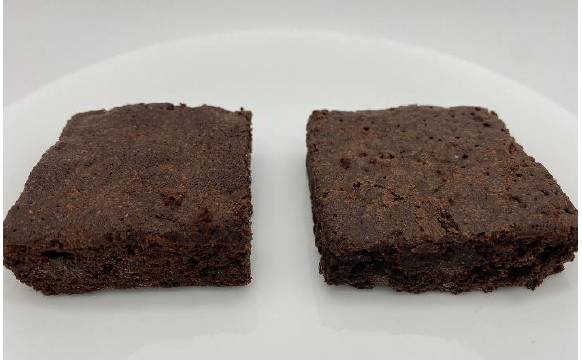
Figure 3. Control ( left ) and CP ( right ) brownies. Table 6. Proximate composition of the baked brownie (on a dry basis) and textural properties of both brownies developed. The means with 95% confidence intervals are shown. All percentages were rounded to the nearest hundredth place. Parameters that were denoted were found to be significantly different ( p < 0.05).